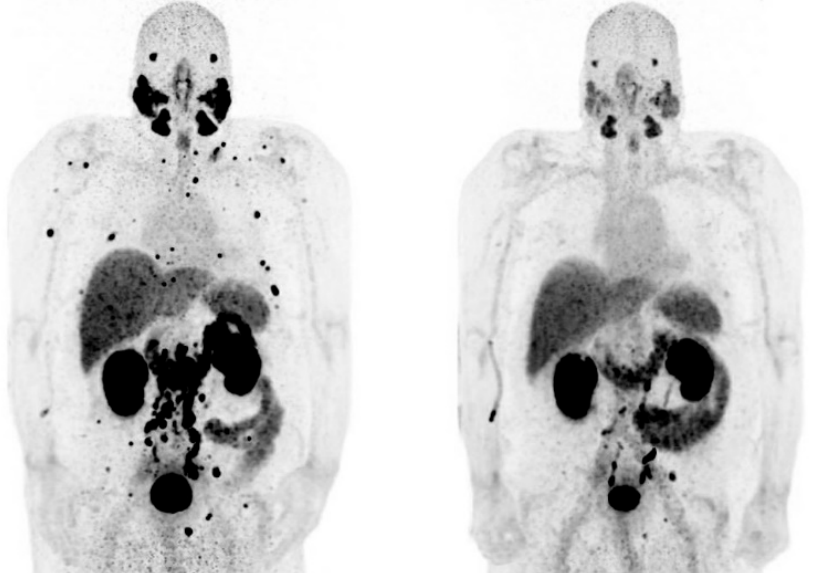
Figure 1. 68 Ga-PSMA I&T PET demonstrating a partial response after 2 cycles of 225 Ac-PSMA I&T in a patient with bone-only mCRPC. Left = before 225 Ac-PSMA I&T therapy. Right = after 225 Ac-PSMA I&T therapy. 225 Ac = actinium-225. 68 Ga = gallium-68. I&T = Imaging and Therapy. mCRPC = metastatic castration-resistant prostate cancer. PET = positron emission tomography. PSMA = prostate-specific membrane antigen.